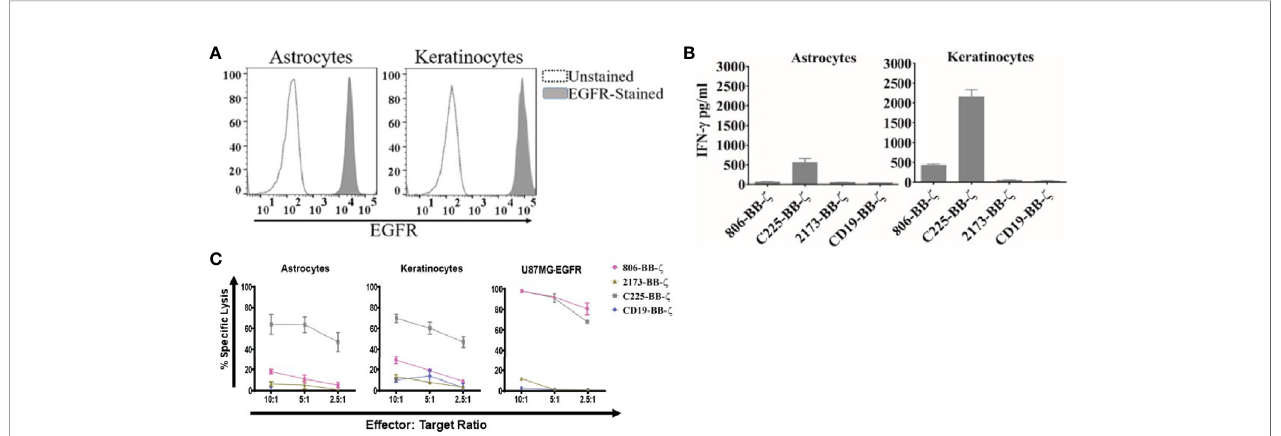
FIGURE 3 | Antitumor ef fi cacy of 806 CAR T cells in primary astrocytes and keratinocytes. (A) Surface expression of EGFR assessed by fl ow cytometry on human primary astrocytes and keratinocytes using EGFR-speci fi c cetuximab antibody. (B) Primary astrocytes and keratinocytes were cocultured with 806 CAR T cells at indicated ratios in a 4-h chromium assay, and results are representative of a single experiment showing the average ± SD of triplicates. (C) Levels of IFN- g measured in supernatants by ELISA 24 h after coculturing 806 and 2173 CAR T cells with primary astrocytes and keratinocytes at an effector-to-target ratio of 1:1. Results are representative of a single experiment with the average ± SD of